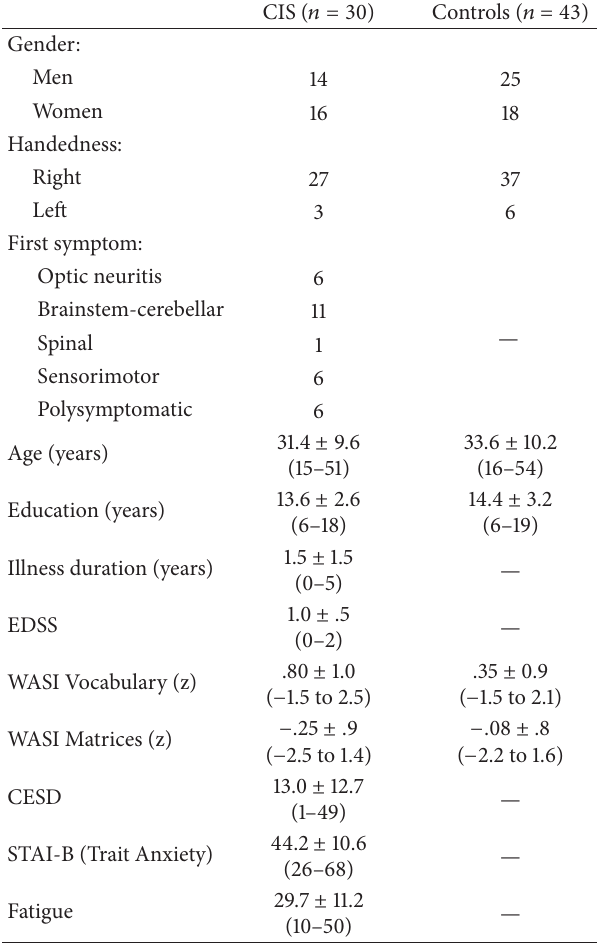
Table 1: Clinical, demographic, and neuropsychological informa- tion on the patients and healthy controls when appropriate (mean ± SD and range in parentheses).